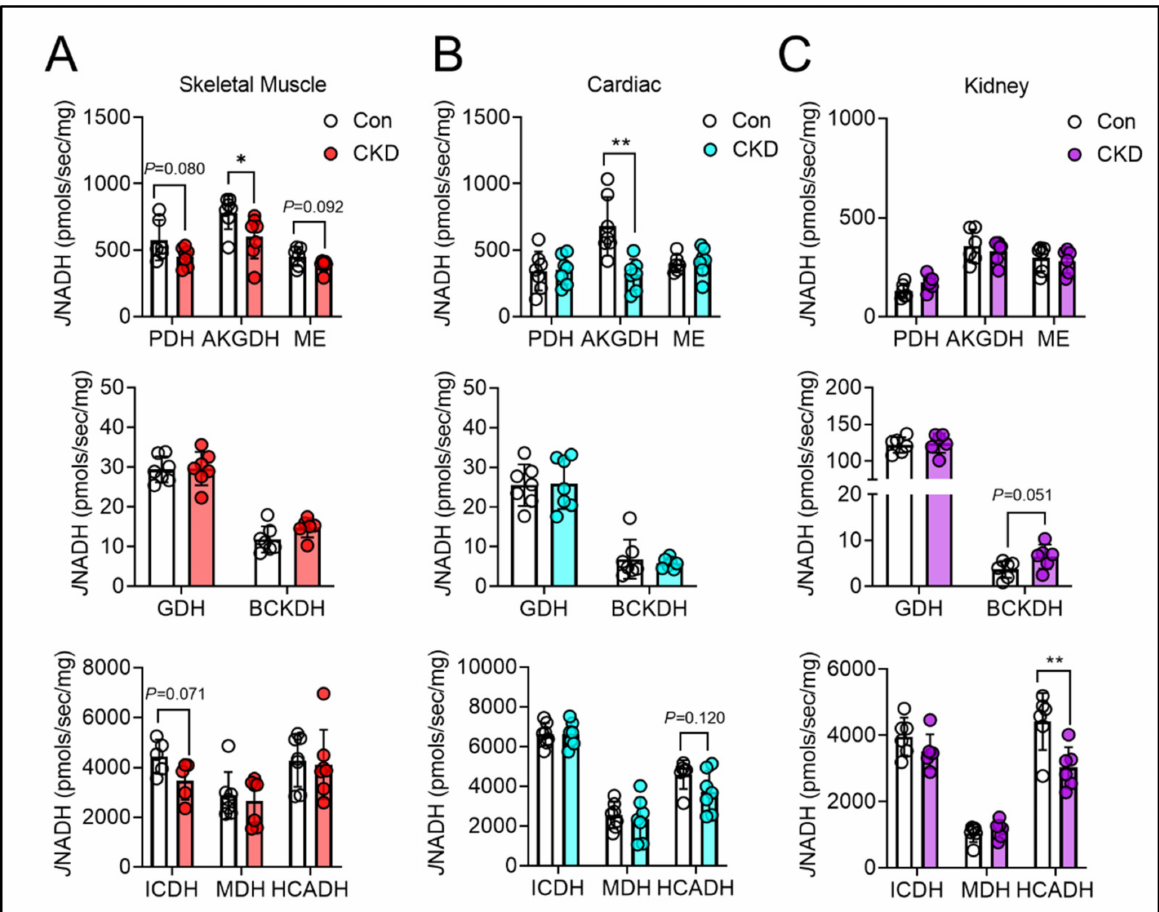
Figure 4. Skeletal muscle, cardiac muscle, and kidney display divergent matrix dehydrogenase activities in CKD. Mitochon- dria from all three tissues were isolated from control and CKD mice and subsequently permeabilized with alamethicin (0.03 mg/mL) or were lysed in cell lytic and underwent freeze thaw cycles for hydroxy-acyl-coA dehydrogenase (HADHA) assays. ( A ) Matrix dehydrogenase activity measured in skeletal muscle mitochondria; ( B ) cardiac muscle; and ( C ) renal mitochondria of the following enzymes: PDH, AKGDH, ME, GDH, BCKDH, ICDH, MDH, and HADHA ( n = 6–7/group). Data were analyzed using two-tailed unpaired t -test. Error bars show standard deviation. p < 0.05 * and p < 0.01